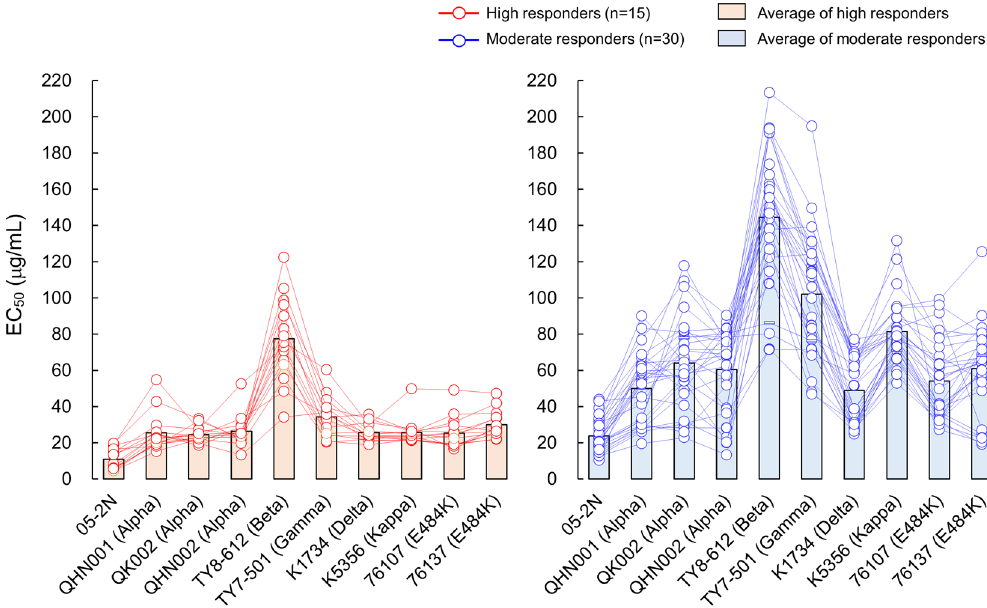
Figure 3. Antiviral activity of IgG fractions eluted from day-60 sera of high and moderate responders against VOCs and VUM. The antiviral activity of IgG fractions eluted from vaccinees’ sera against 9 SARS-CoV-2 variants was evaluated. A Wuhan strain SARS-CoV-2 05-2N was employed as a reference SARS-CoV-2. Left panel shows results of high responders (n = 15), whereas right panel shows the results of moderate responders (n = 30). The EC 50 values of each IgG against SARS-CoV-2 variant are shown in red (high responders) or blue (moderate responders) circles, and bar represent average EC 50 value of each group. P values for the difference between SARS-CoV-2 05-2N and each variant of high responders or moderate responders: < 0.001 (QHN001), < 0.001